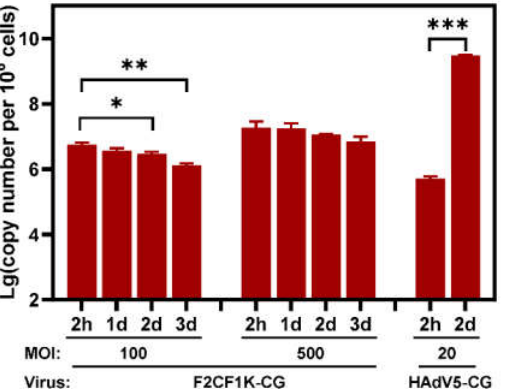
Figure 5. Detection of viral genome in adenovirus infected 293 cells. Human 293 cells in 6-well plates were infected in duplicate with F2CF1K-CG at MOIs of 100 or 500 vp/cell for 2 h. Total DNA in cells plates were infected in duplicate with F2CF1K‑CG at MOIs of 100 or 500 vp/cell for 2 h. Total DNA was extracted immediately after incubation (2 h) or at indicated time points (1, 2 or 3 days) post- post‑infection. Taqman probe‑based real‑time PCR was performed in triplicate to determine